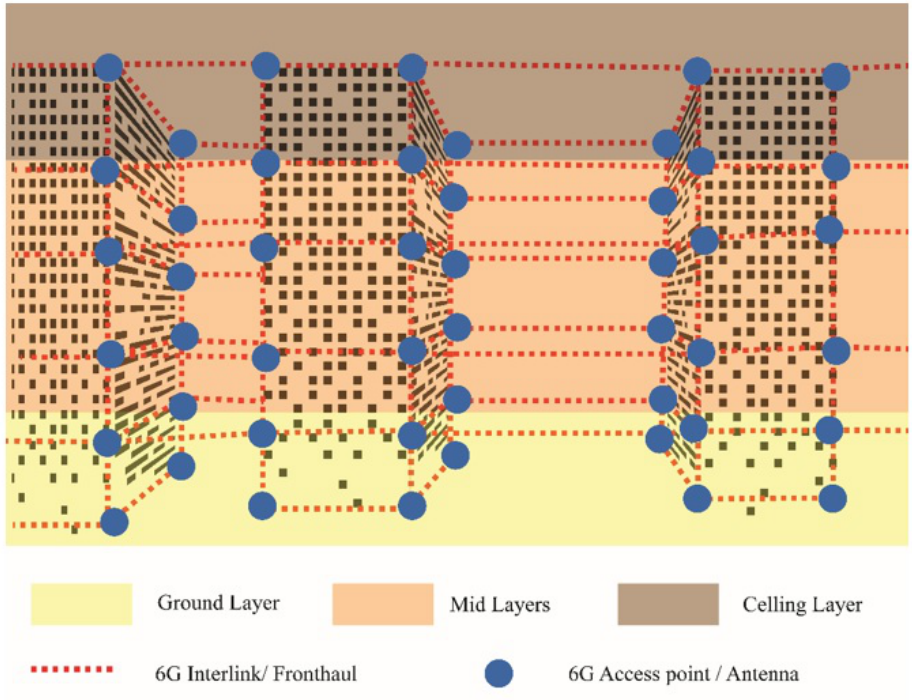
Figure 9. Multilayer networks connectivity in futuristic